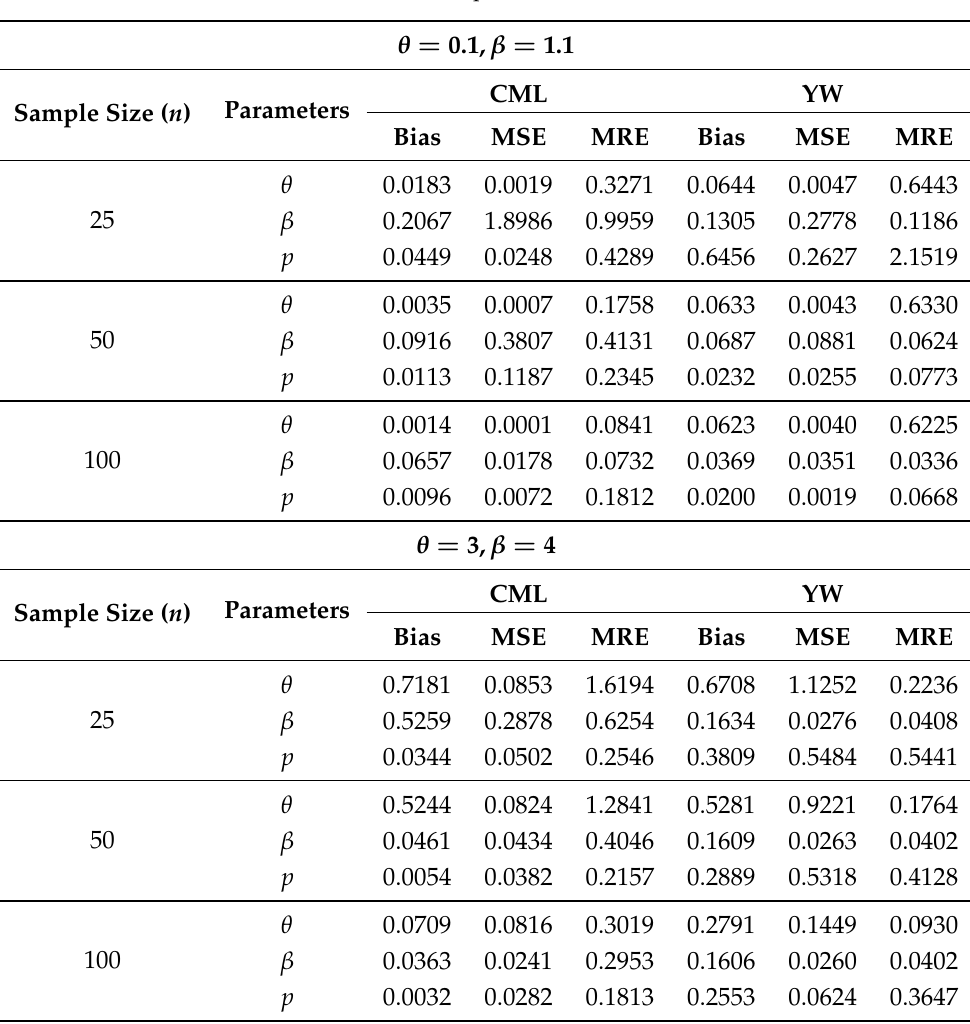
Table 8. Simulation results of the INAR(1)DPsL